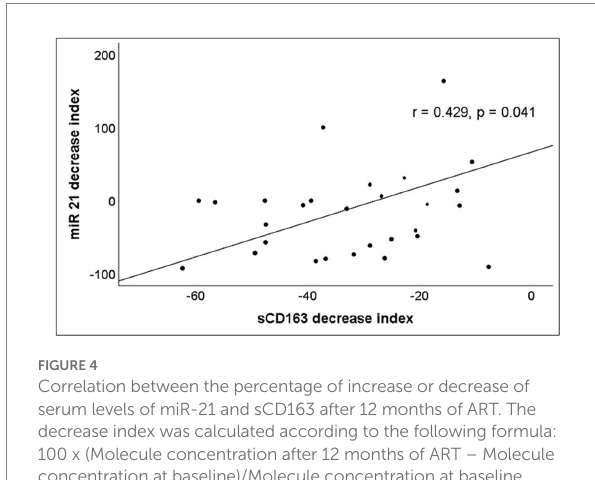
FIGURE 4 Correlation between the percentage of increase or decrease of serum levels of miR-21 and sCD163 after 12 months of ART. The decrease index was calculated according to the following formula: 100 x (Molecule concentration after 12 months of ART – Molecule concentration at baseline)/Molecule concentration at baseline.